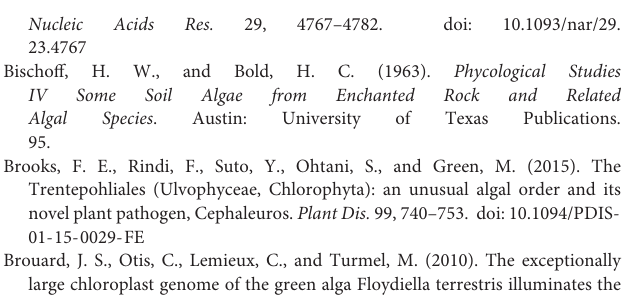
1242 Trentepohlia sp . chloroplast